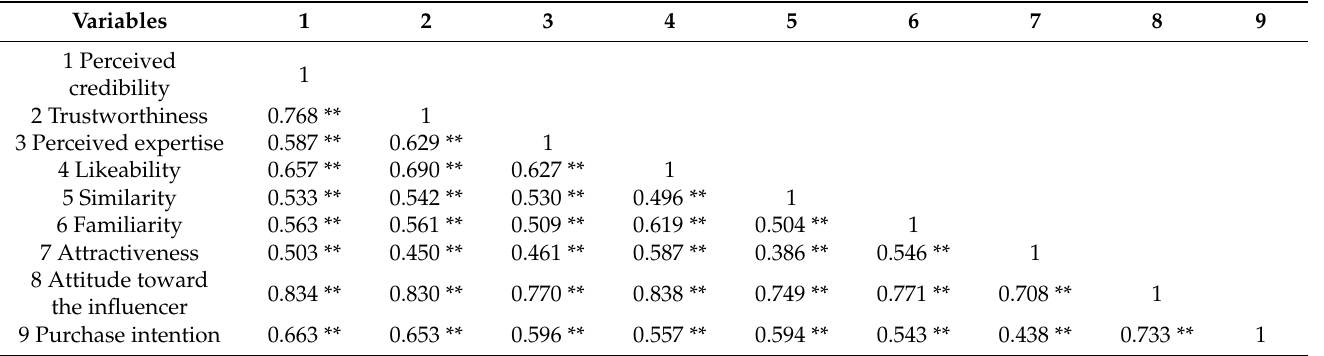
Table 4. Correlations between independent variables and dependent variables.